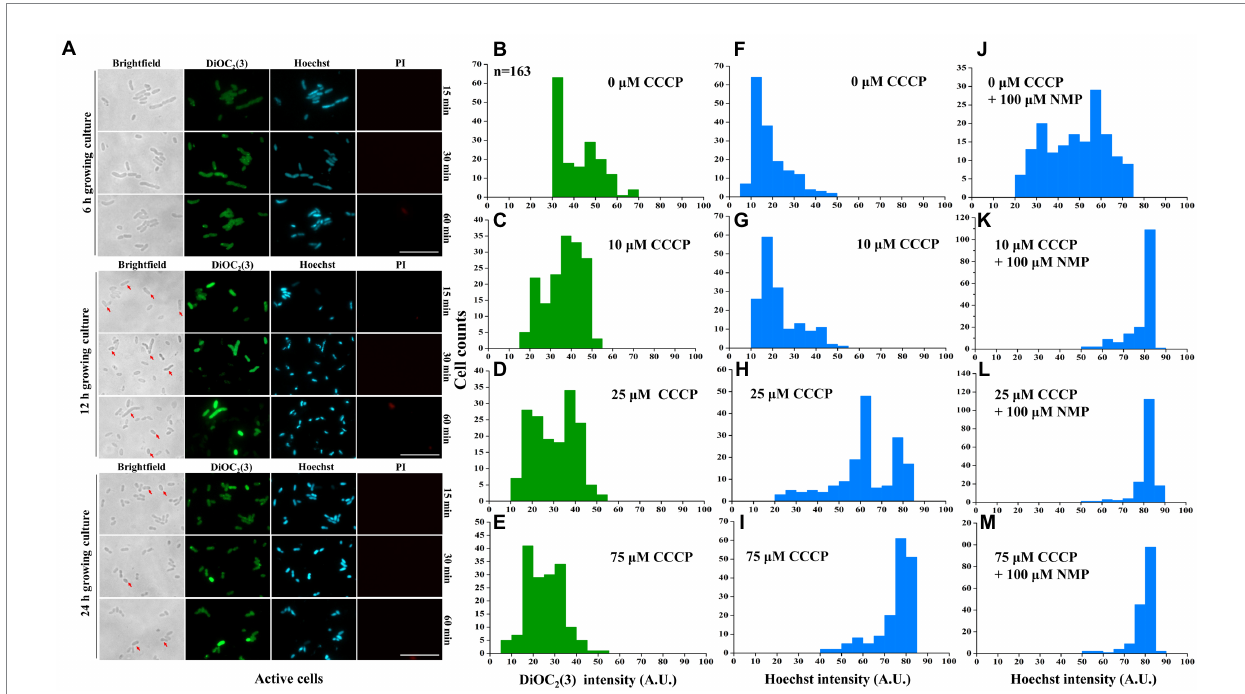
FIGURE 5 Inhibition of purine metabolism is associated with intracellular tetracycline accumulation via activation of membrane potential-dependent efflux. The negative correlation was detected between DiOC 2 (3) and Hoechst 33342 fluorescence intensities in active cells (A) . The distribution of DiOC 2 (3) (B–E) and Hoechst 33342 fluorescence intensity (F–I) was further assayed with different concentrations of CCCP treatments. Similarly, Hoechst 33342 fluorescence intensity was also anlyzed after efflux pump inhibitor NMP treatment (J–M) . More than 167 cells were analyzed for each condition. The scale bar of the figure was 10 μ M. The microscopy settings were the same across all the